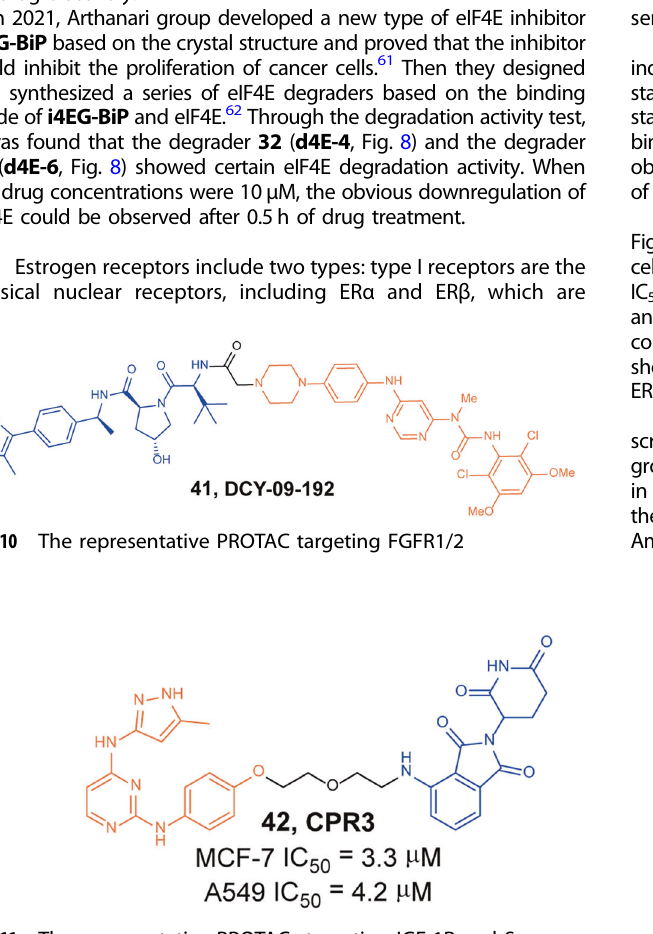
Fig. 11 The representative PROTACs targeting IGF-1R and